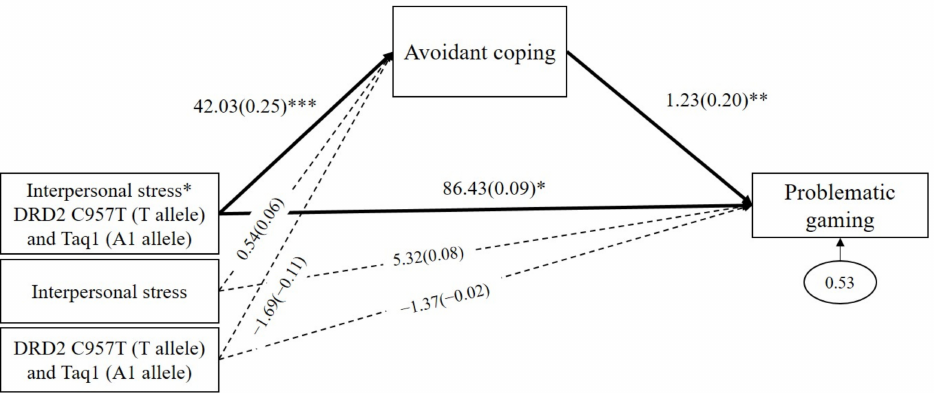
Figure 5. Mediated moderation model with avoidant coping as the mediator in the interaction effect of combined DRD2 polymorphisms and interpersonal stress on problematic gaming. Sex, impulsivity, depression, anxiety, and ADHD were controlled for in all analyses (paths not shown for simplicity). Unstandardized (outside parentheses) and standardized (inside parentheses) coefficients are shown. Solid lines represent statistically significant coefficients. Dashed lines represent statistically insignificant coefficients; * p < 0.05, ** p < 0.01, and *** p < 0.001. Table 3. Conditional indirect